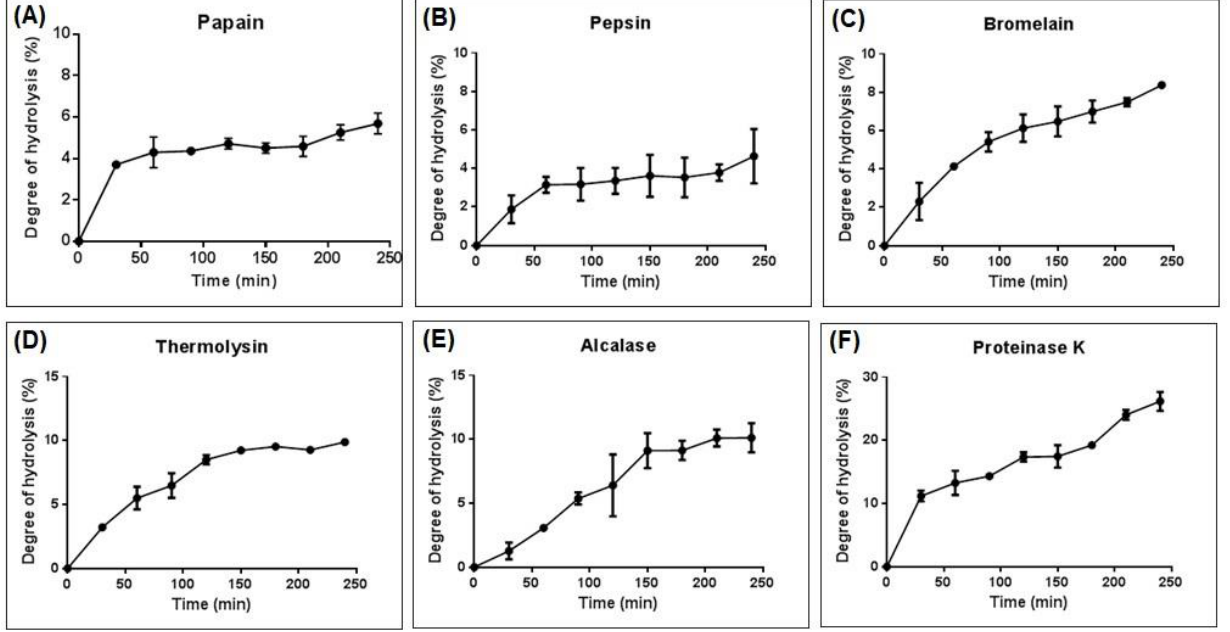
Figure 5. Degree of hydrolysis (%) of mackerel steaming juice (MSJ) powder hydrolyzed for 4 h using ( A ) papain, ( B ) pepsin, ( C ) bromelain, ( D ) thermolysin, ( E ) alcalase and ( F ) proteinase K.